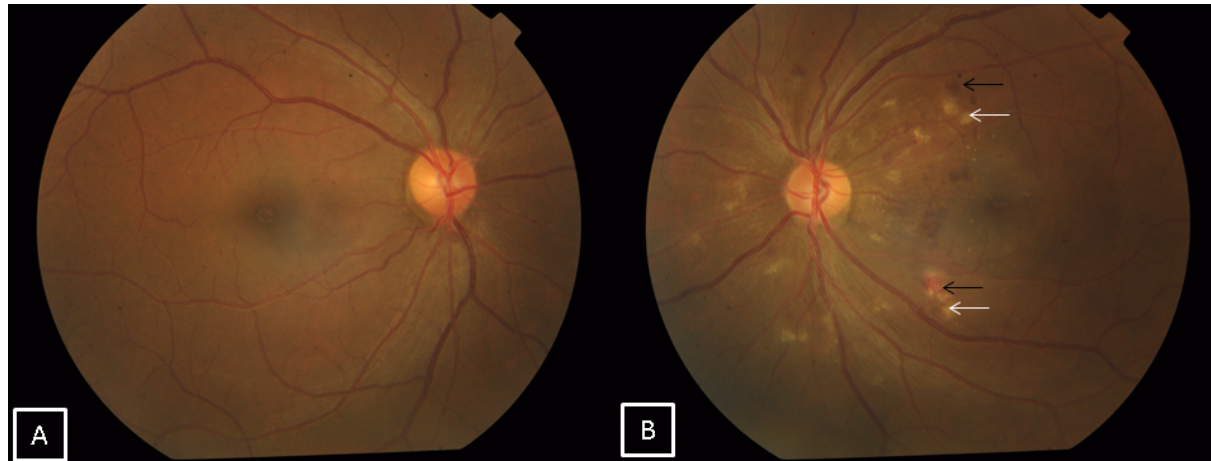
Figure 2: A) Normal fundus of the right eye. B) Fundus of the left eye showing multiple cotton wool spots (white arrows) with superficial retinal hemorrhages (black arrows) on the posterior pole.